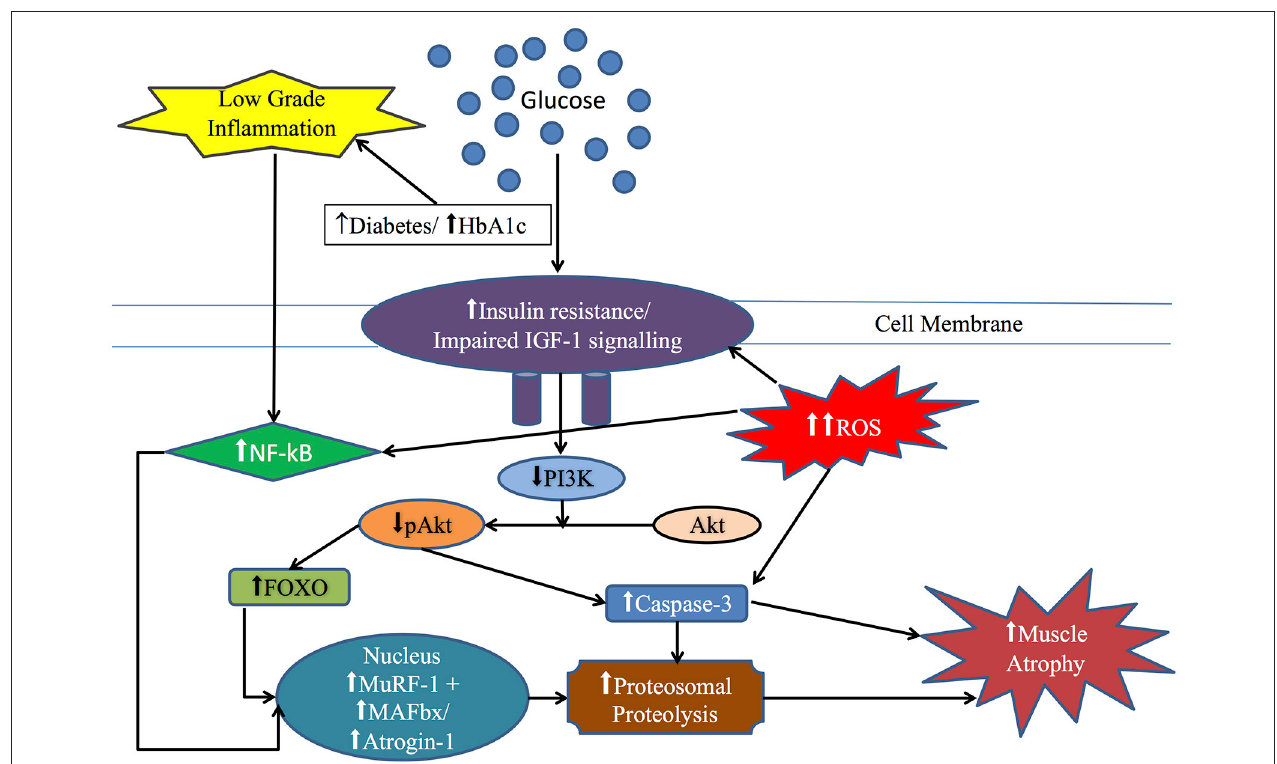
FIGURE 2 | Diagrammatic representation of the overlap between insulin signaling pathway, reactive oxygen species (ROS), inflammatory cytokine such as NF- κ B and ubiquitin-proteasome system in insulin resistant (IR) states particularly diabetes: In IR state, PI3K activity is decreased, leading to decreased activity of Akt, which in turn release the inhibition of FOXO and caspase-3 resulting in elevation of muscle ring finger-1 (MuRF-1) and muscle atrophy F-box (MAFbx/atrogin-1) finally leading to increased proteolytic activity. Also, ROS and low grade inflammation via NF- κ B pathway lead to muscle atrophy. See text for more